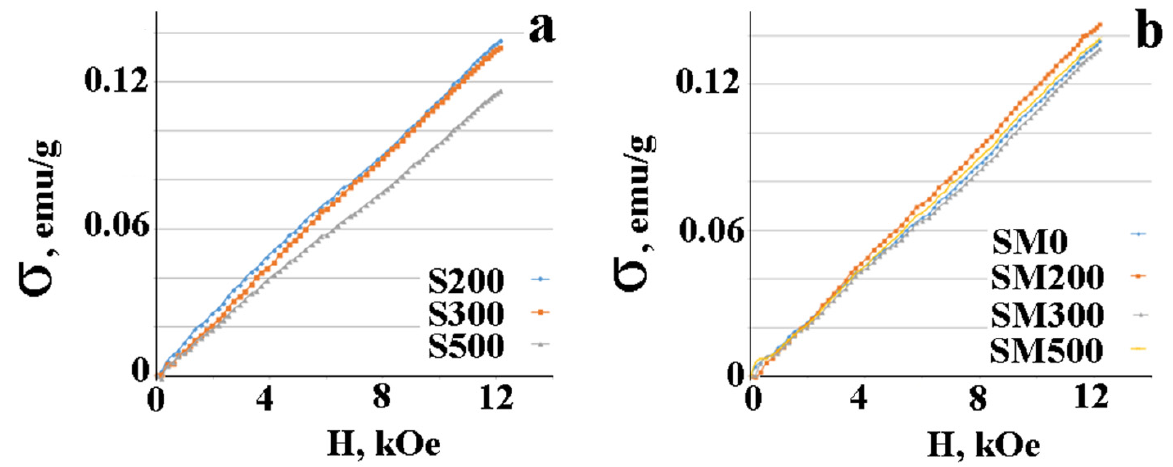
Figure 6. ( a ) Specific magnetization of CeF 3 NPles annealed in air at temperatures of 200, 300 and 500 °C; ( b ) specific magnetization of commercial CeF 3 powder annealed in air at temperatures of 200, 300 and 500 °C.